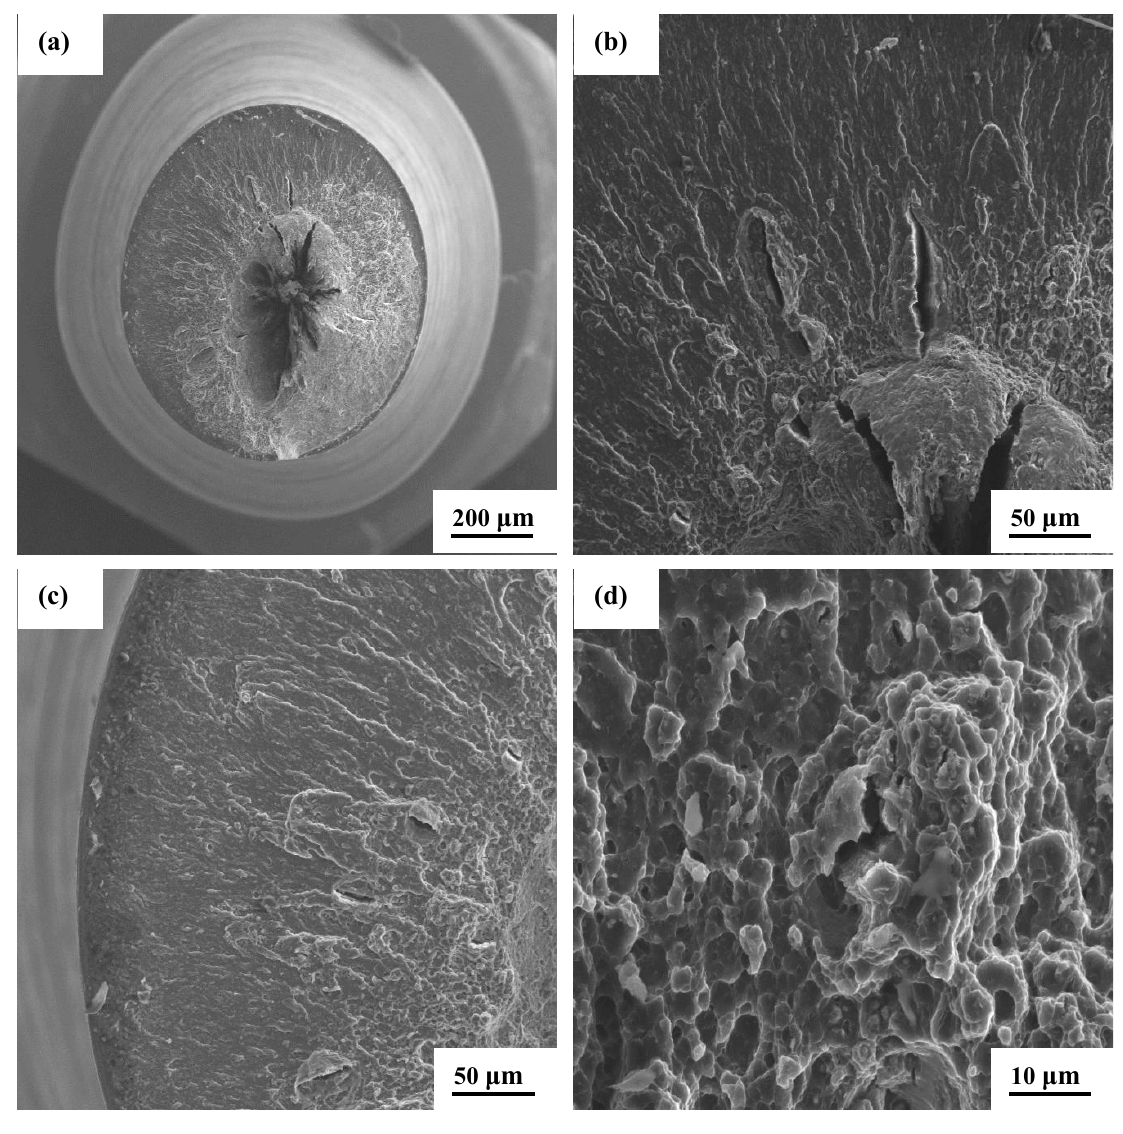
Figure 7. Scanning electron micrographs of the high cycle fatigue fracture surface of O containing 1.5 wt pct nickel deformed at maximum cyclic stress of AZ31 + Al 2 3 183.14 MPa at load ratio of 0.1, fatigue life of 15,009 cycles, showing the following: ( a ) Overall morphology of failure; ( b ) High magnification observation of (a) showing the transgranular fracture surface with isolated macroscopic cracks; ( c ) The transition region between fatigue and overload showing the distinctly different features on the fracture surface and ( d ) High magnification observation of the transition region showing isolated pockets of shallow